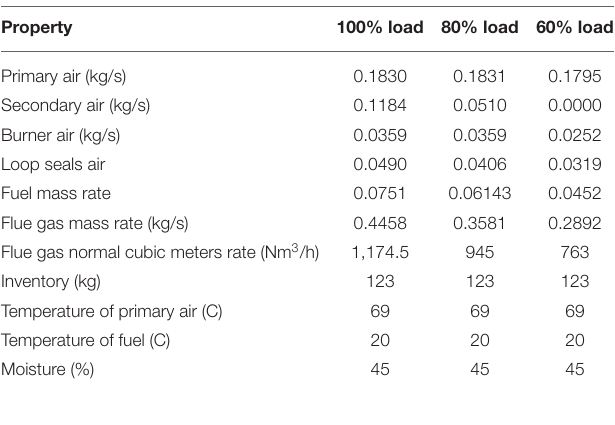
TABLE 2 | Operational data of the three examined loads for the steady-state simulations. Property